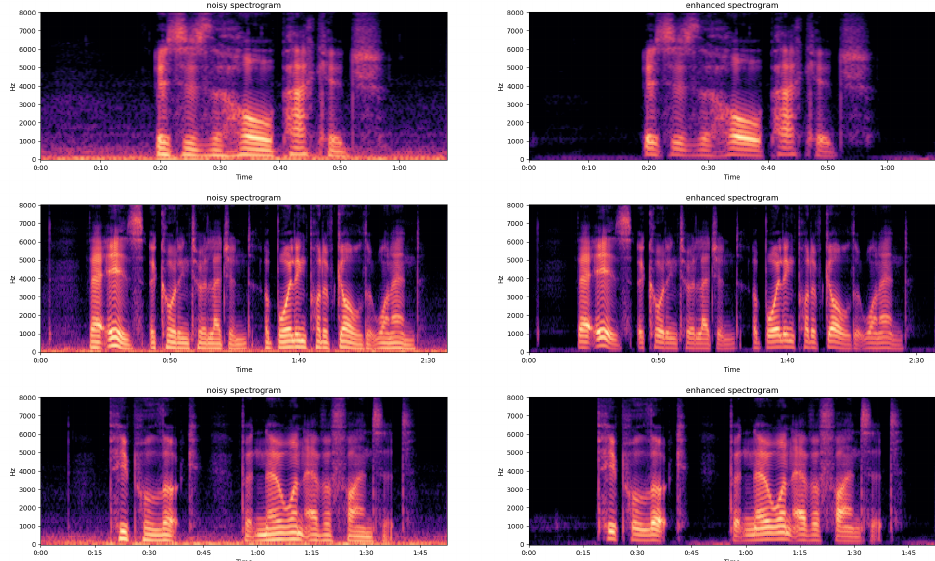
Figure 10. A comparison of the Mel spectrograms of the noisy speech and the enhanced speech, where the left is the noisy speech and the right image is the enhanced speech.